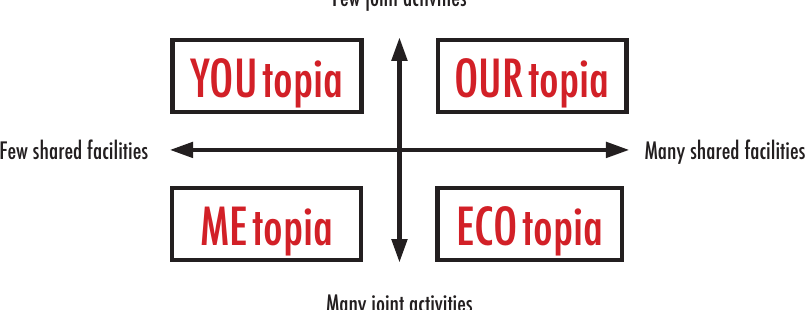
Figure 2. Scheme illustrating cohousing typologies. Source: Adapted from Camp (2018, p. 22). Urban Planning, 2022, Volume 7, Issue 1, Pages